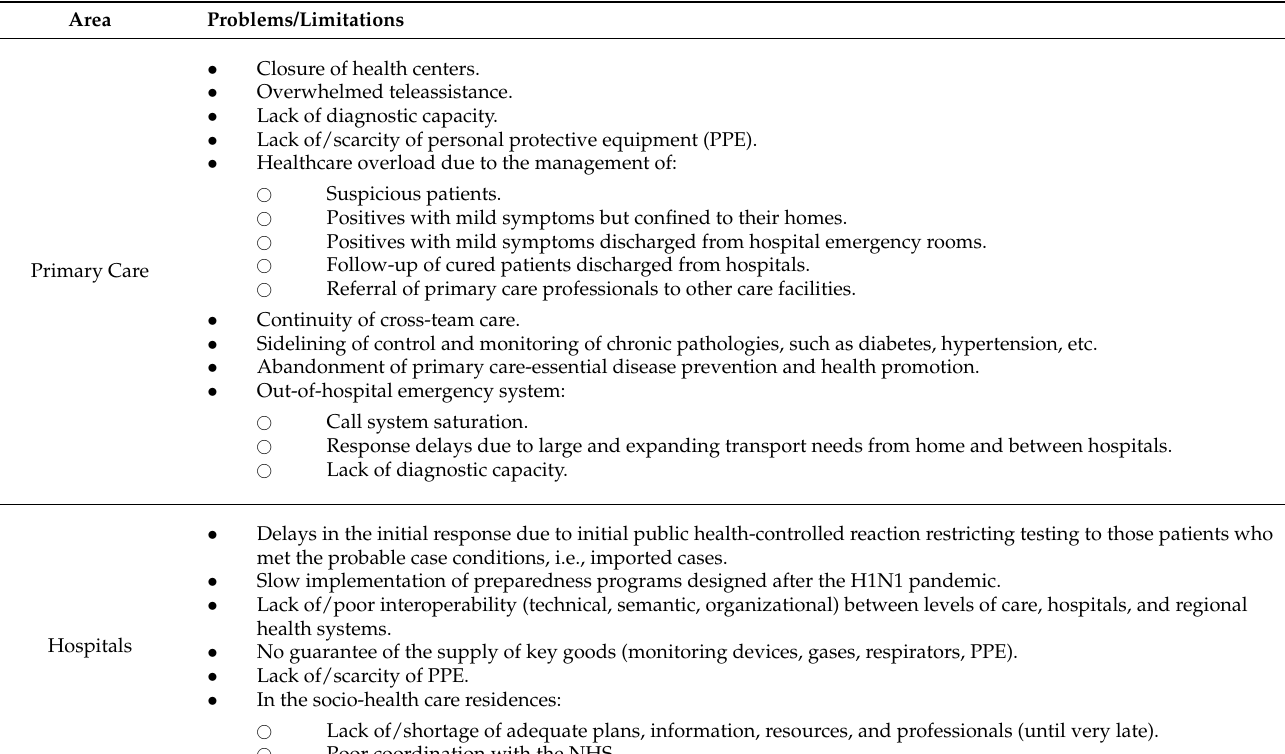
Table 1. Limitations of the Spanish health